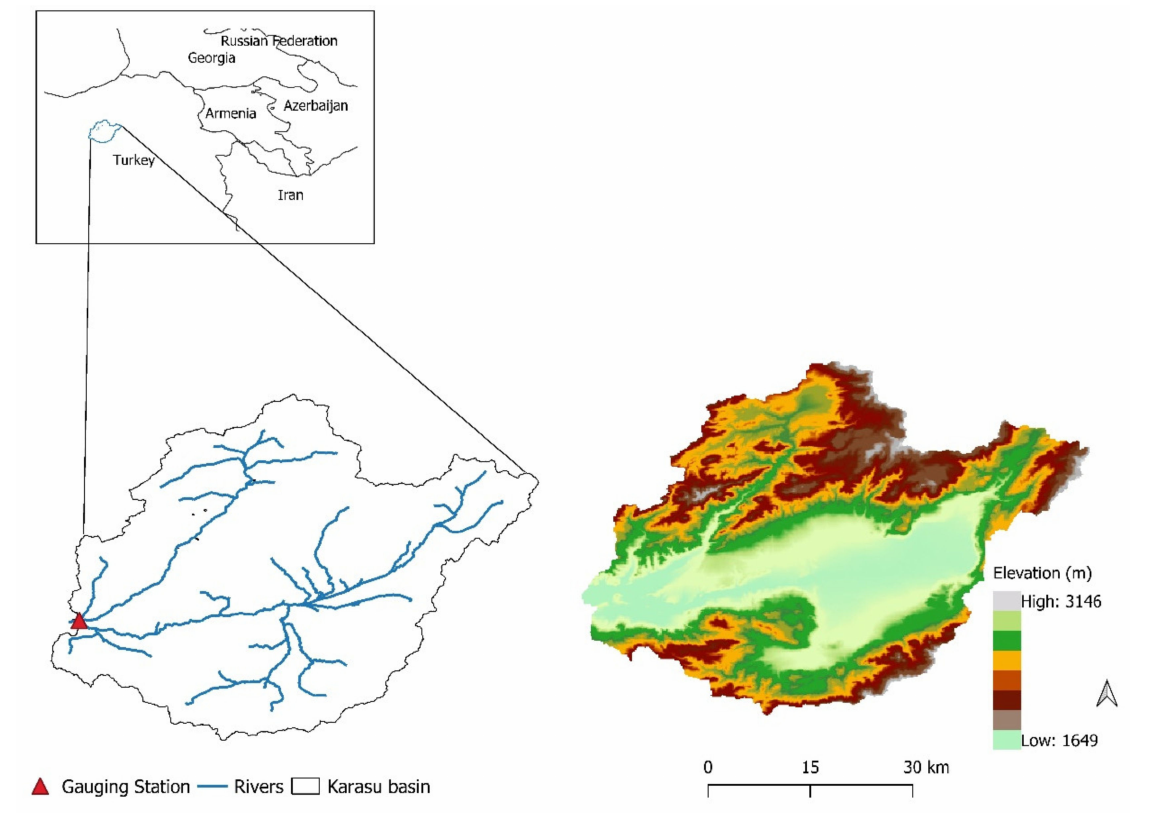
Figure 1. The location of the Karasu Basin and the